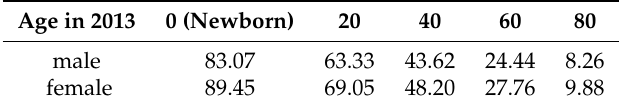
Table 4. Curtate future life time e a , g ( T ) for males and females in